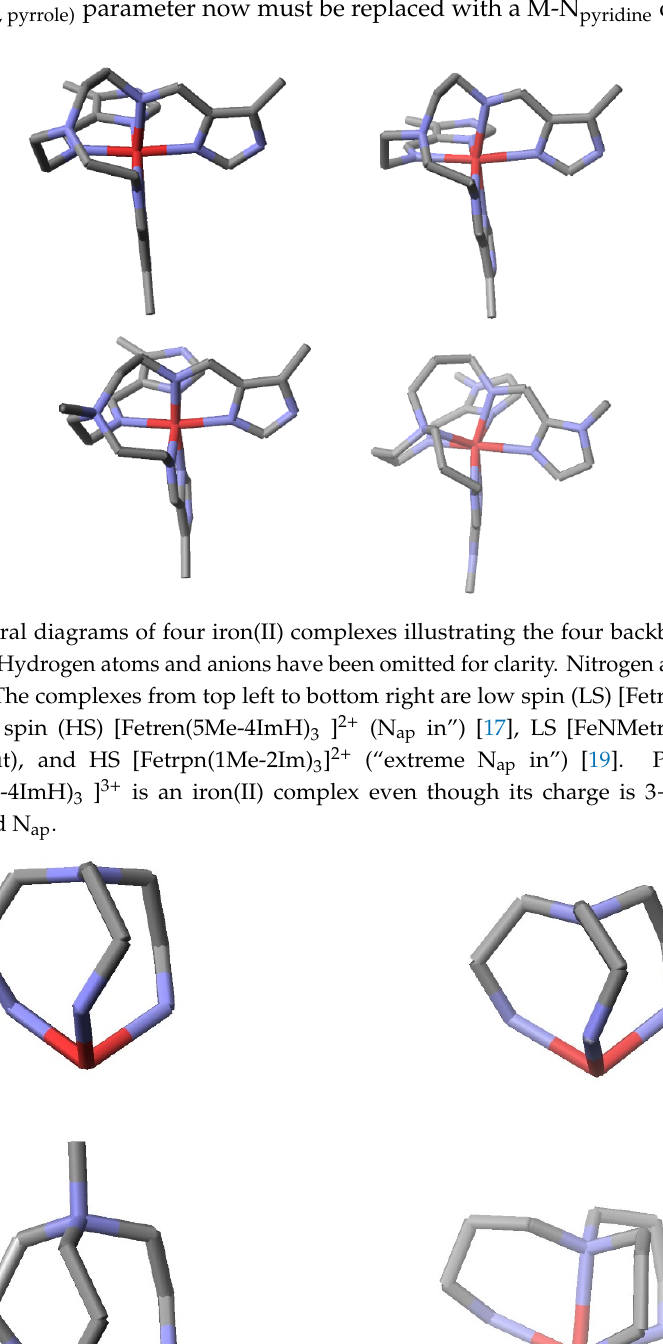
Figure 3. Structural diagrams of the four iron(II) complexes of Figure 2 showing only the iron and backbone atoms of tripodal ligands. The orientations place N ap directly above the iron atom. The structural parameters, Fe-N imine , Fe-N axole , Fe-N ap , N imine –Fe-N azole , and C-N ap –C, of these complexes are as follows: LS [Fetren(5Me-4ImH) 3 ] 2 + (P) (1.978 Å, 1.972 Å, 3.527 Å, 80.9970 ◦ , 119.829 ◦ ) [17], HS [Fetren(5Me-4ImH) 3 ] 2 + (N ap in”) (2.185 Å, 2.206 Å, 3.050 Å, 75.665 ◦ , 115.454 ◦ ) [17], LS [FeNMetren(5Me-4ImH) 3 ] 3 + (‘N ap out) (1.956 Å, 1.960 Å, 3.920 Å, 81.867 ◦ , 113.554 ◦ ) [17], and HS [Fetrpn(1Me-2Im) 3 ] 2 + (“extreme N ap in”). (2.2746 Å, 2.2437 Å, 2.4476 Å, 72.8 ◦ , 107.79 ◦ ) [19].